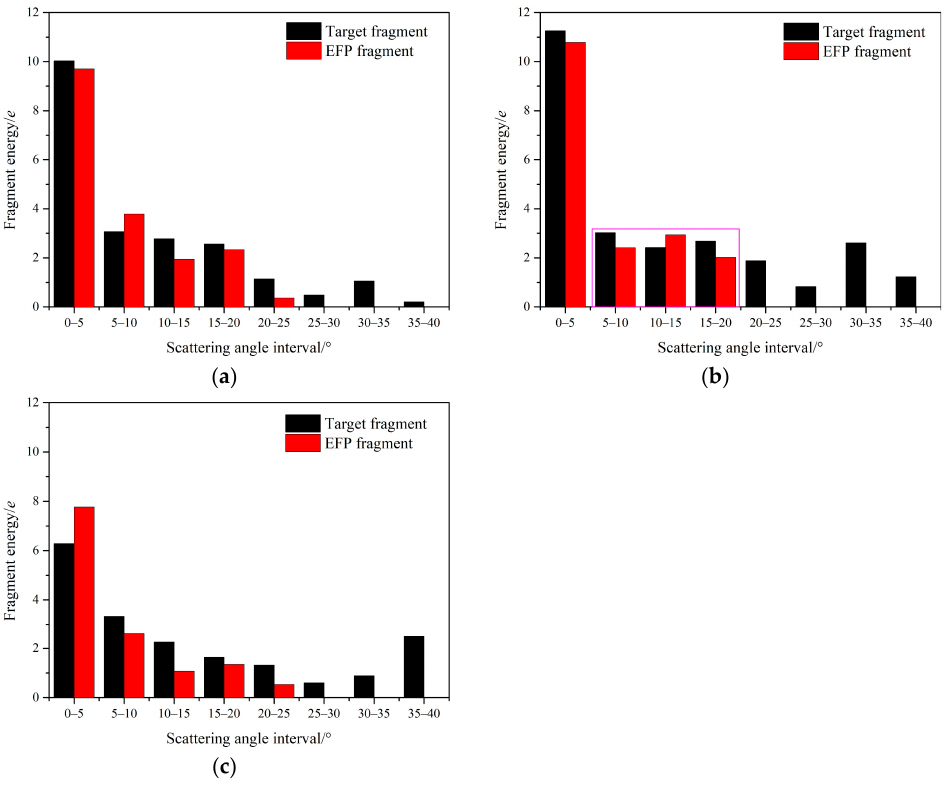
Figure 14. Average energy distribution of EFP and target fragments in different scattering angle ranges. ( a ) L / D = 1.66 ( b ) L / D = 2.4 ( c ) L / D = 3.86. ranges. ( a ) L / D = 1.66 ( b ) L / D = 2.4 ( c ) L / D =